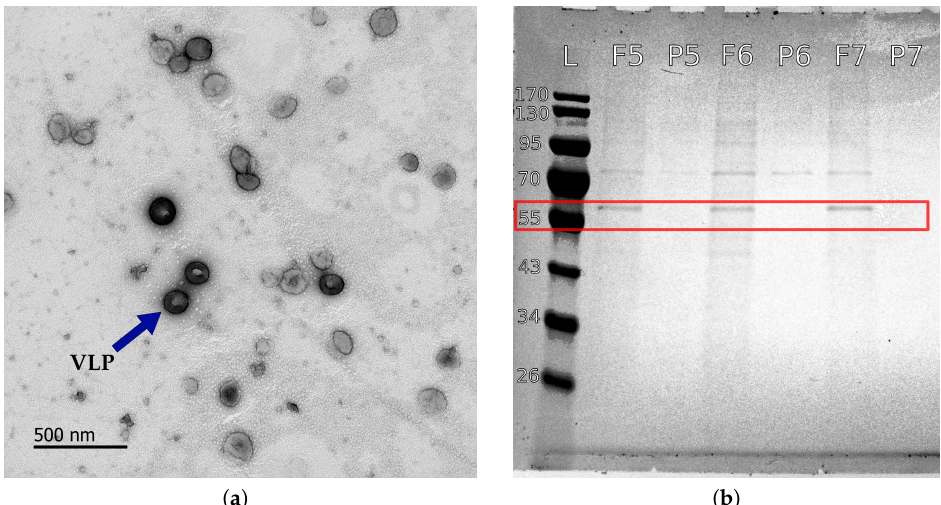
Figure 4. TEM image of a purified VLP suspension ( a ) and an SDS-Page of trail 5 to 7 feed (F) and permeate (P) sample after UF. The Mosaic p55-Gag precursor proteins in VLP are shown (red frame) ( b ). L represents a marker ladder.